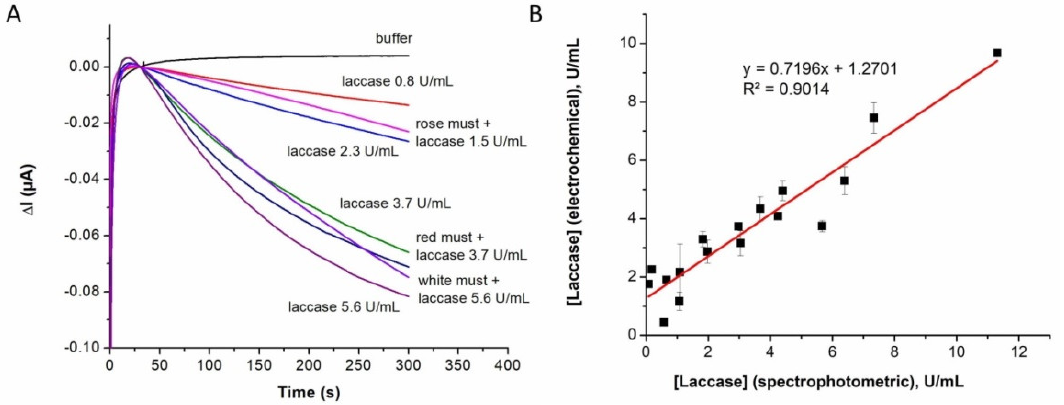
Figure 6. ( A ) Current versus time plots for red, rosé, and white musts with added laccase of 1.5, 3.7, and 5.6 U/mL. ( B ) Correlation of the proposed paper-assisted electrochemical assay with the spec- trophotometric method based on